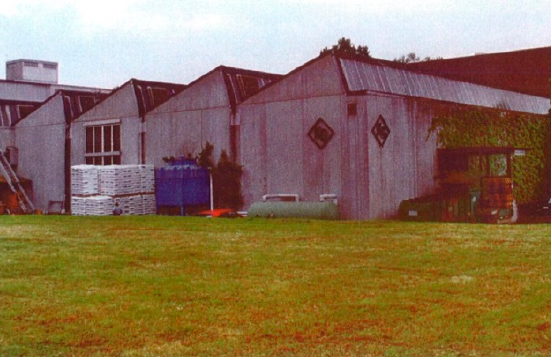
Figure 11. Industrial building in Kreuzlingen in Switzerland, which was strengthened in 1970 by means of steel plates.